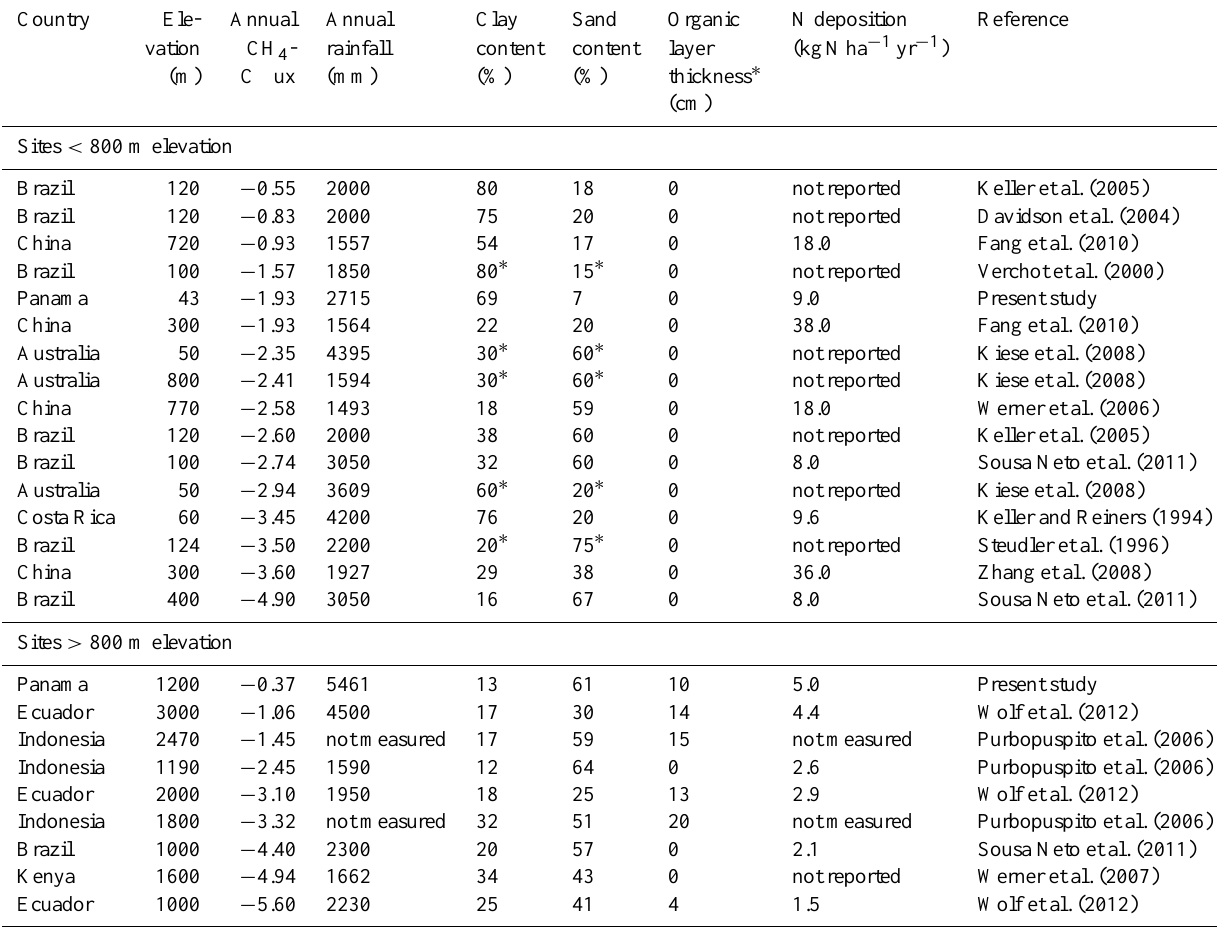
Table 3. Compilation of CH 4 -C fluxes (kgCH 4 -Cha − 1 yr − 1 ) from soils of old-growth (sub)tropical forests, sorted from smallest to largest uptake rates within each elevation